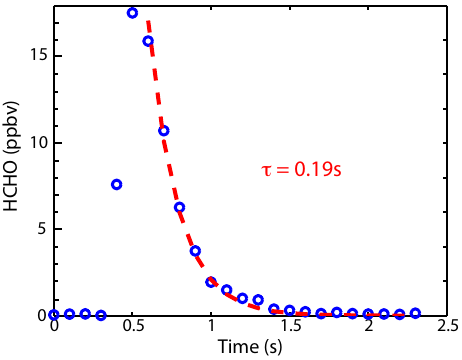
Figure 9. The mean normalized Allen deviation is shown for 60min of sampling at a constant HCHO concentration of 5.1ppbv. The short integration times show a τ − 1 / 2 increase in precision, consis- tent with white noise.